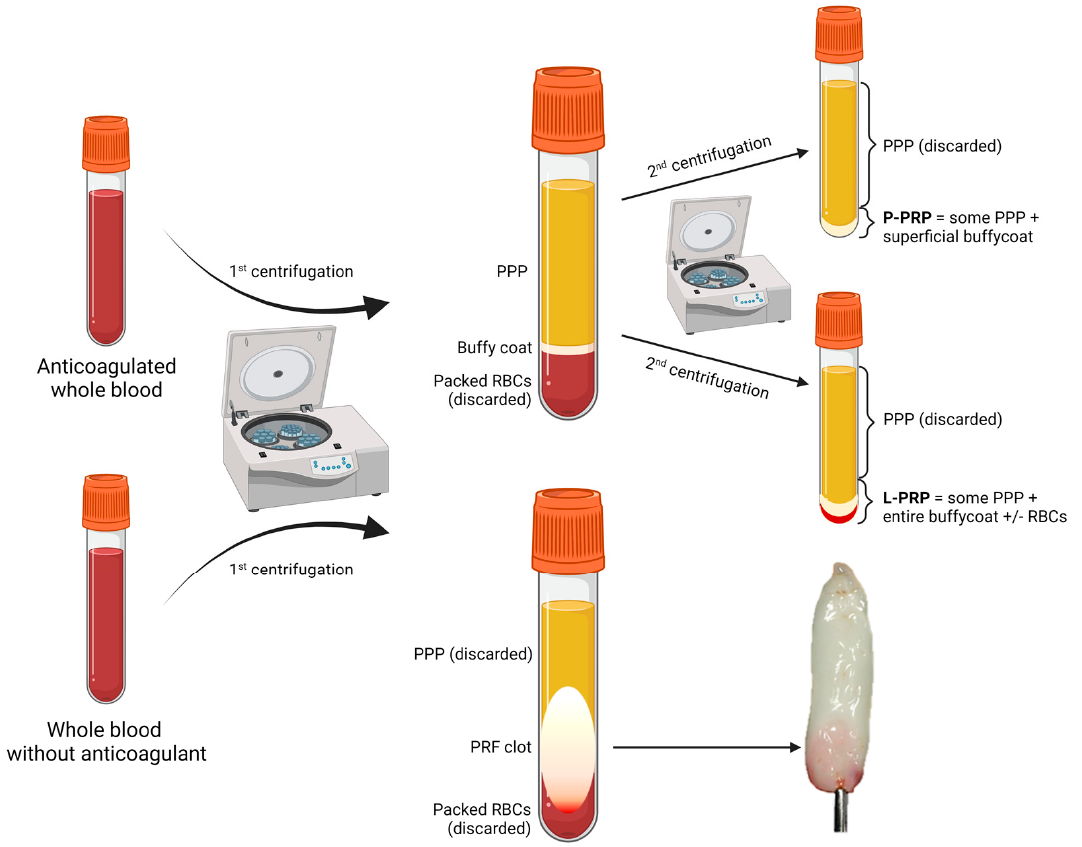
Figure 1. Platelet concentrate processing techniques. The upper part of the figure shows the prepa- ration of P-PRP and L-PRP. The centrifugation steps allow the separation into PPP, buffy coat, and packed RBCs. The main difference between P-PRP and L-PRP derives from the amount of buffy coat collected between the first and the second centrifugation steps. In the lower part of the figure, PRF preparation is displayed: after blood collection in tubes without anticoagulant, a flexible and malleable fibrin clot is obtained through centrifugation. Created in BioRender.com (accessed on 17 Fabruary 2023). Abbreviations: L-PRP, leukocyte and platelet-rich plasma; PPP, platelet-poor plasma; P-PRP, pure platelet-rich plasma; RBC, red blood cell.